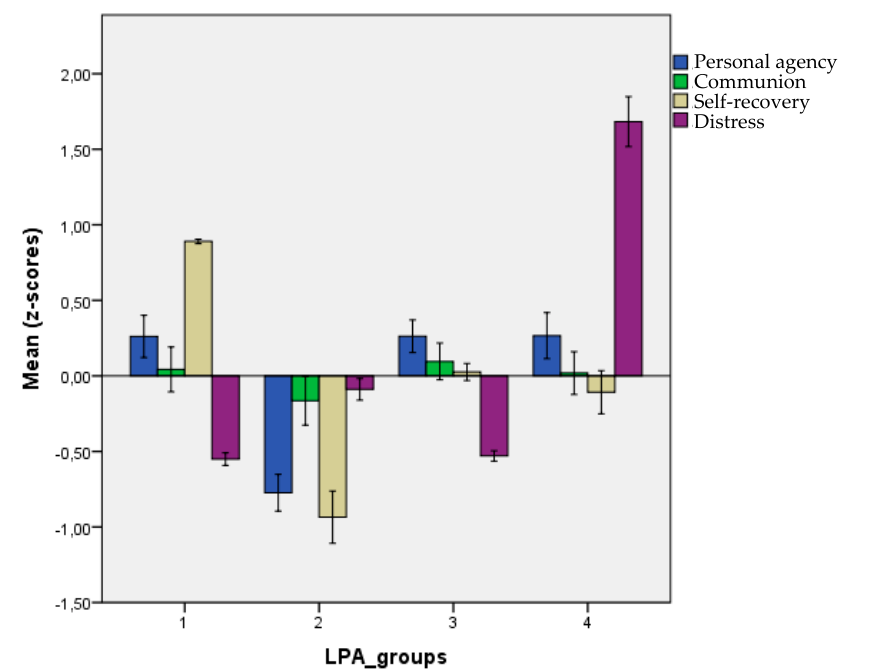
Figure 1. Profiles of the latent profile groups. Note: LP1 = “security in active self-recovery”; LP2 = “security in retreat”; LP3 =“security in doing and feeling good enough”; LP4 = “security in stress and compensation”. Dimension scores are standardized factor scores with +/ − 2 SE error